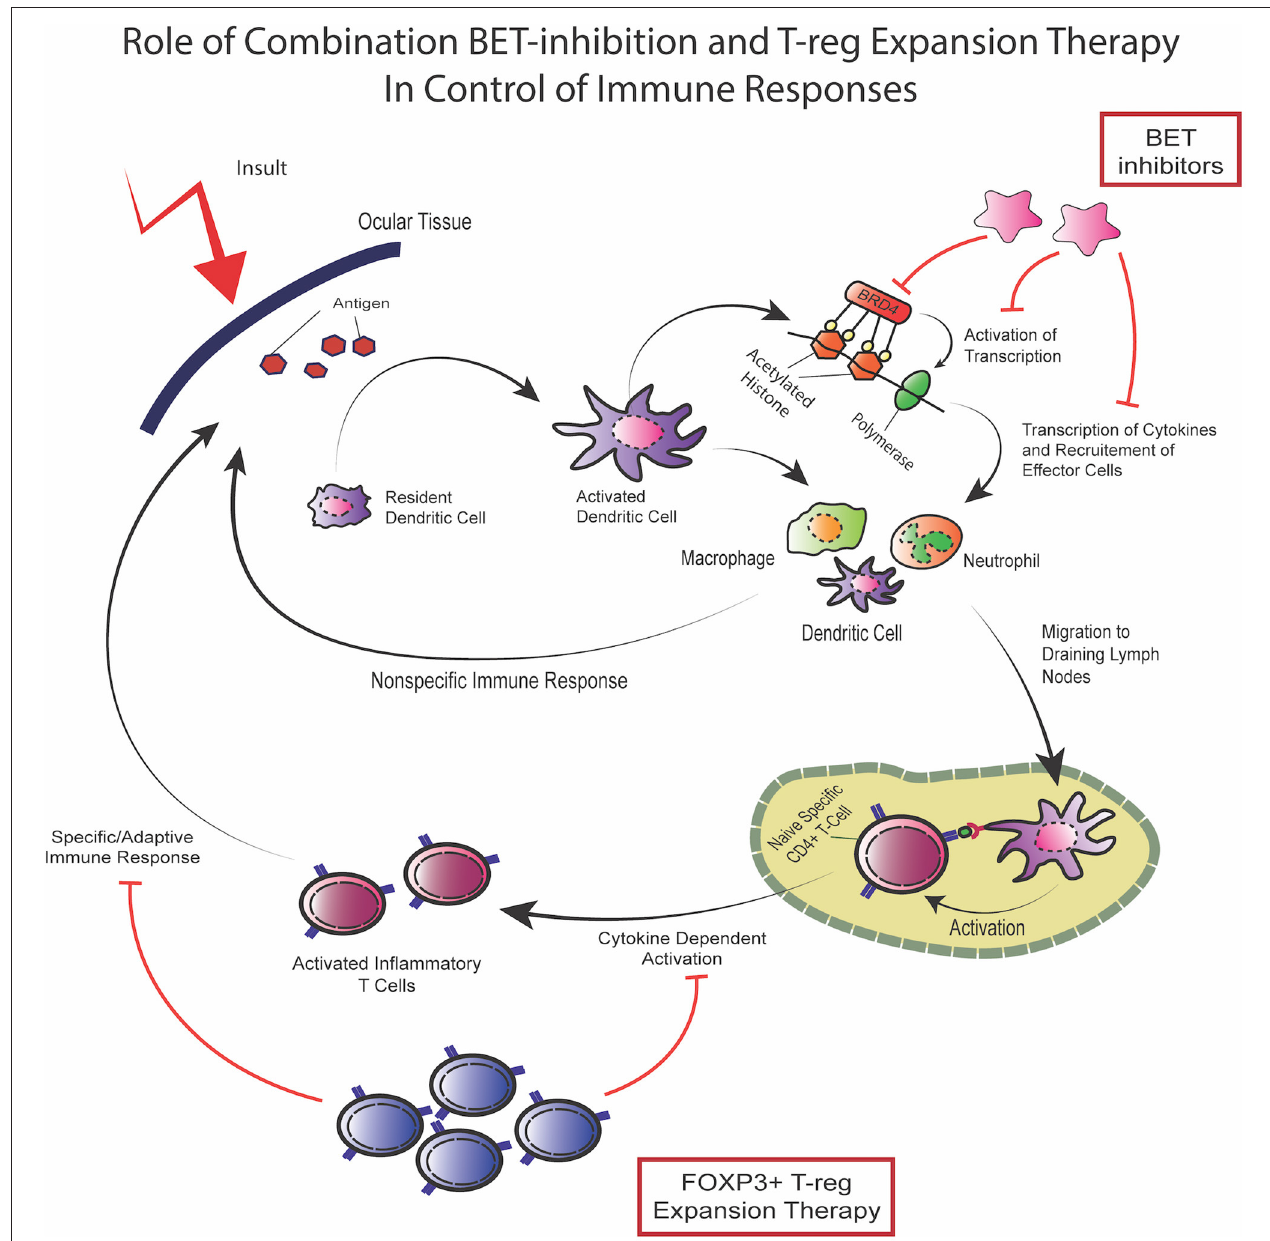
FIGURE 2 | Combination of BET inhibition and T-reg expansion to target immune responses. In response to the presentation of novel antigens, as in the case of an ocular surface transplant, the resident immune cells activate and, through bromodomain-regulated activation of transcription, produce inflammatory cytokines which leads to recruitment of effector cells which carry out non-specific innate immune response. In addition, activated immune cells may also function as antigen presenting cells through MHC-II expression and migrate to draining lymph nodes where activation of antigen specific CD4 + T-cells takes place resulting in cytokine dependent specific immune response activation of the adaptive immune response. Dual therapy using BET-inhibitors mainly targeting the cytokine-dependent innate response along with T-reg expansion therapy targeting the activation of the adaptive response can potentially control immune responses and suppress inflammatory disease. The two modalities have been shown to not interfere with one another and can effectively provide a compound strategy for inflammatory control.